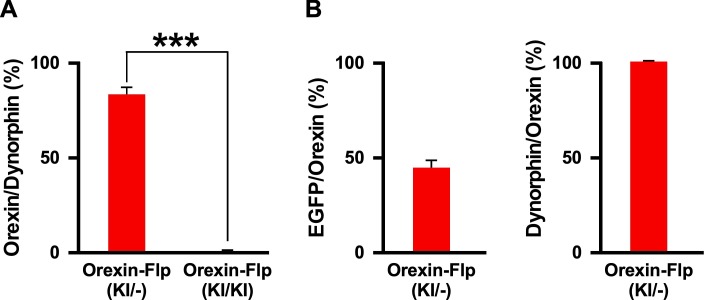
Immunohistochemical expression analysis in OF (KI/-) and OF (KI/KI) mice.(A) Co-expression analysis showing dynorphin-positive neurons are also positive for orexin immunoreactivity in OF (KI/-) and OF (KI/KI) mice (n = 3 mice each). (B) Bar diagram showing the co-expression analysis in OF (KI/-) mice (n = 3 mice). The p value was determined using two-tailed unpaired student’s t-test. Data represent mean ± SEM.10.7554/eLife.44927.007Figure 3—figure supplement 1—source data 1.Source data for Figure 3—figure supplement 1A and B.